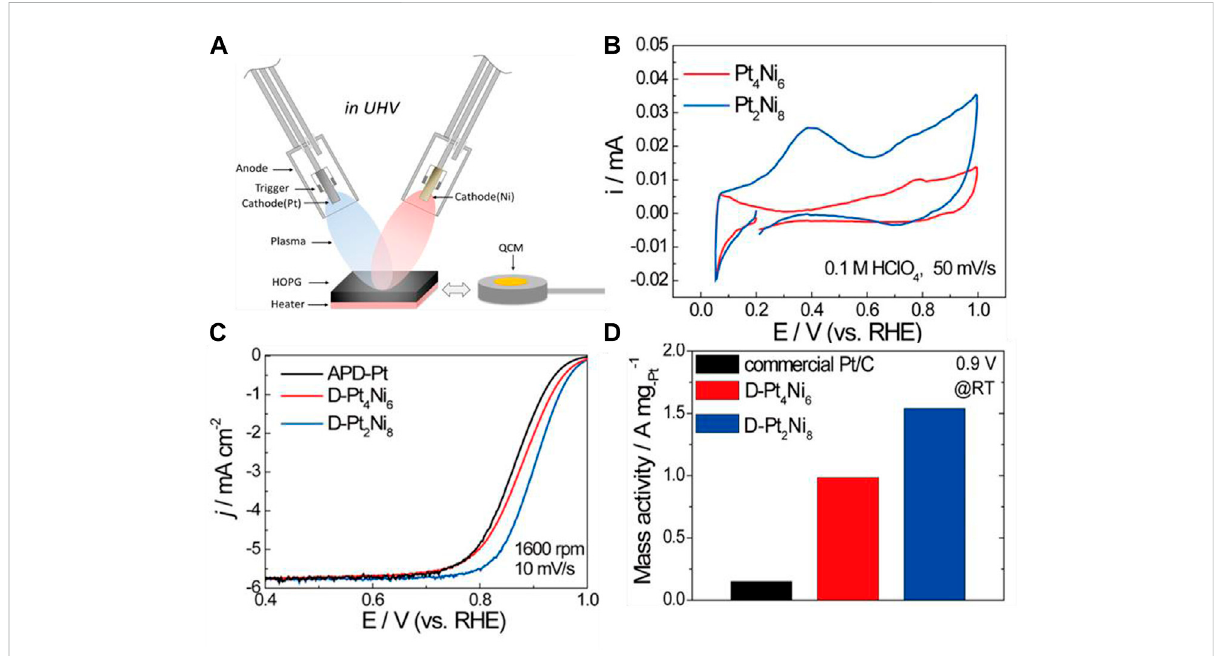
FIGURE 5 (A) Illustration of the arc-plasma deposition of Pt-Ni catalyst; (B) cyclic voltammograms (CV) for Pt voltammograms (LSV) for the ORR of as-prepared fi lms; and (D) Pt-mass activities for the as-prepared fi lms and commercial Pt/C. Reproduced